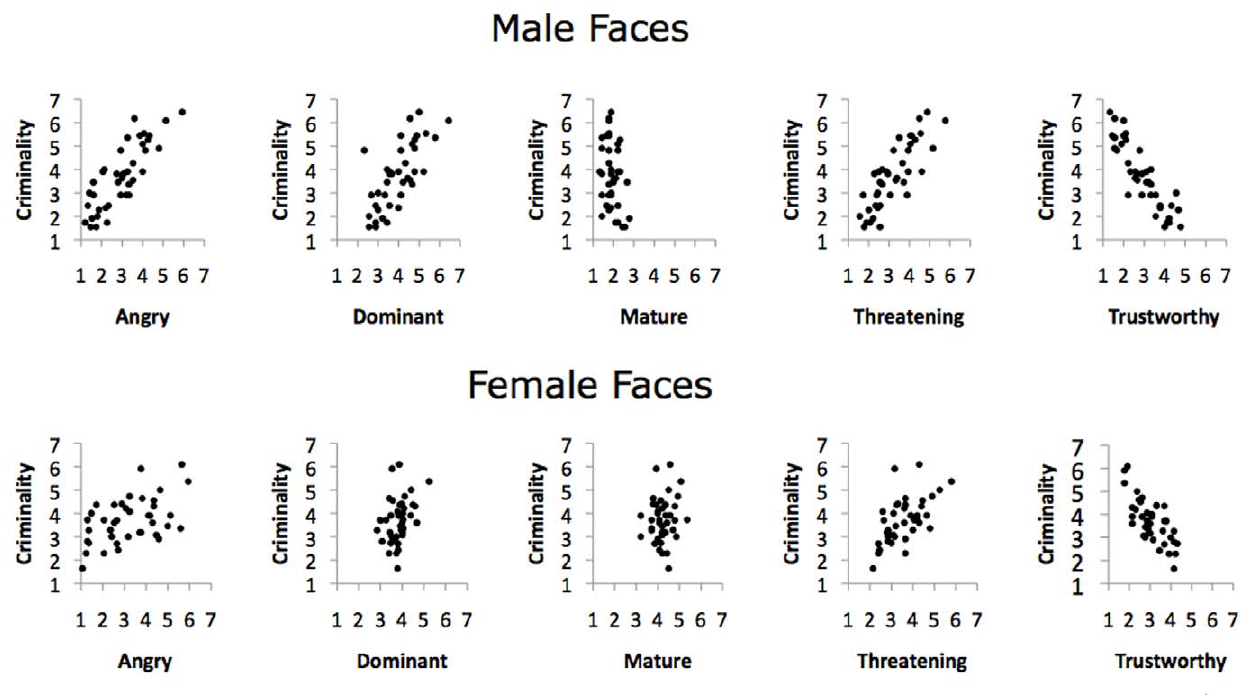
Figure 1. Scatterplots illustrating the bivariate relationship of criminality with the other attributes measured for the naturalistic photos by face gender.